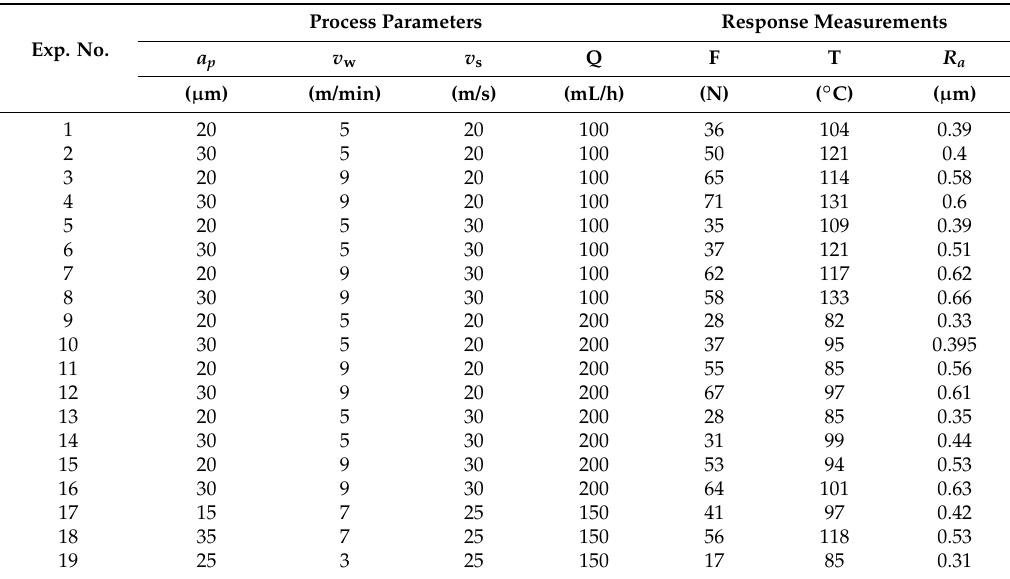
Table 4. Design matrix for MQL-assisted